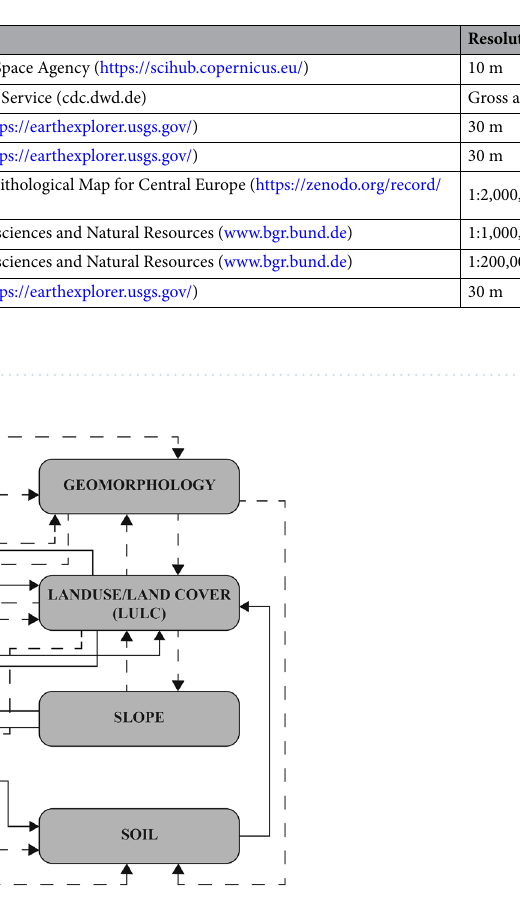
Figure 4. Inter-relationship between the influencing factors of the potential groundwater recharge zone.